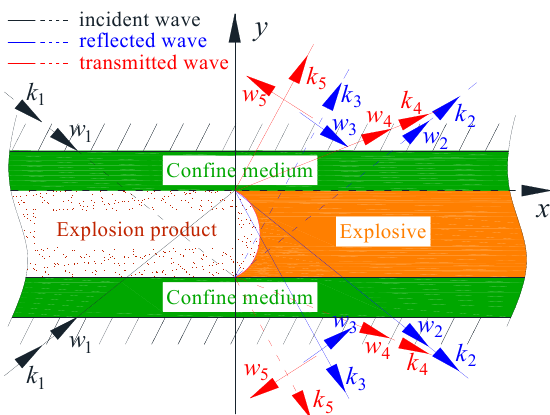
Figure 5. Transmission and reflection of detonation waves at an interface between two media.